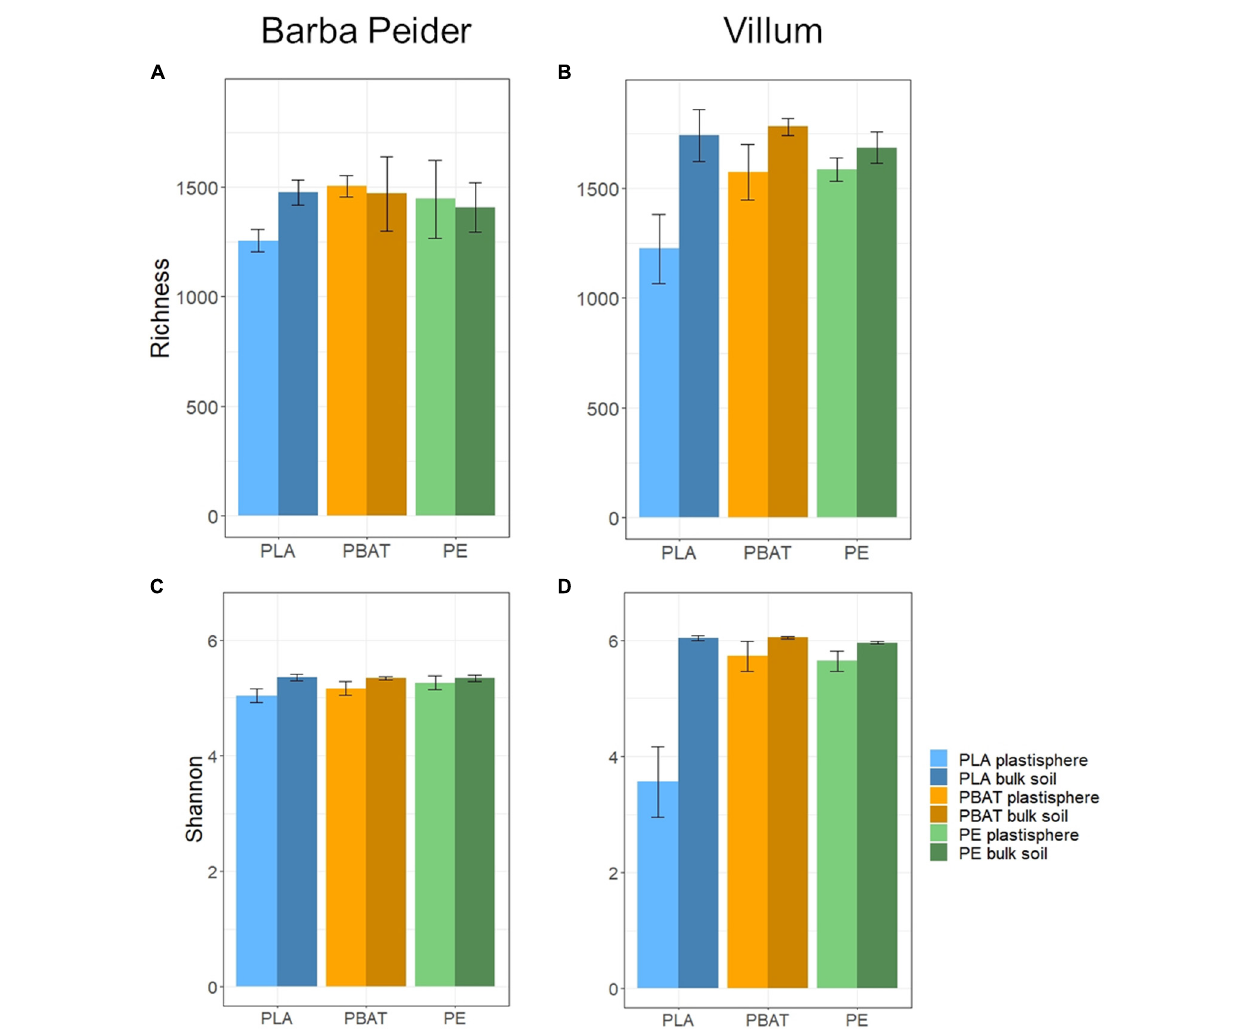
FIGURE 1 | Prokaryotic α -diversity (mean ± sd; n = 3) of plastisphere and bulk soil samples showing observed richness (A,B) and Shannon Index (C,D) in Barba Peider (Swiss Alps) (A,C) and Villum (Northern Greenland) (B,D)